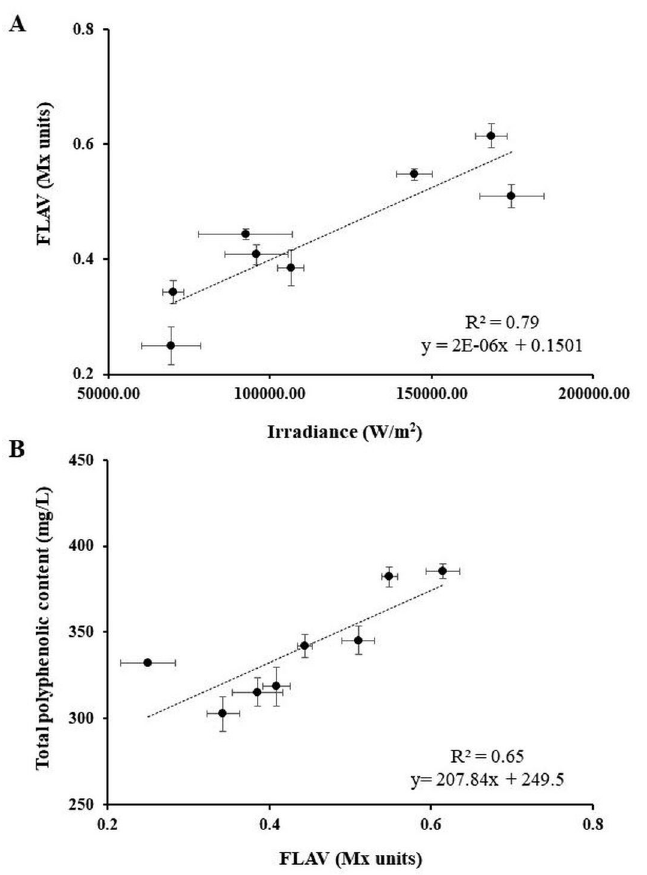
Fig 6. Correlation between FLAV index, environmental factors and grape juice phenolic compounds. Correlation between FLAV (Mx units) at DOY 243 and cumulative irradiance (W/m 2 ) recorded in the corresponding bunch-zone during the berry development period (A), and between FLAV and the total polyphenolic content of berry juice at grape ripeness (mg/L) (B). Trend lines, R 2 coefficient and linear equations are reported in each graph. Each dot represents the average value of three replicates for each variable recorded in the 2018 vintage in Ep-1 and Te-1. Standard errors of each variable are displayed according to the specific axis position.